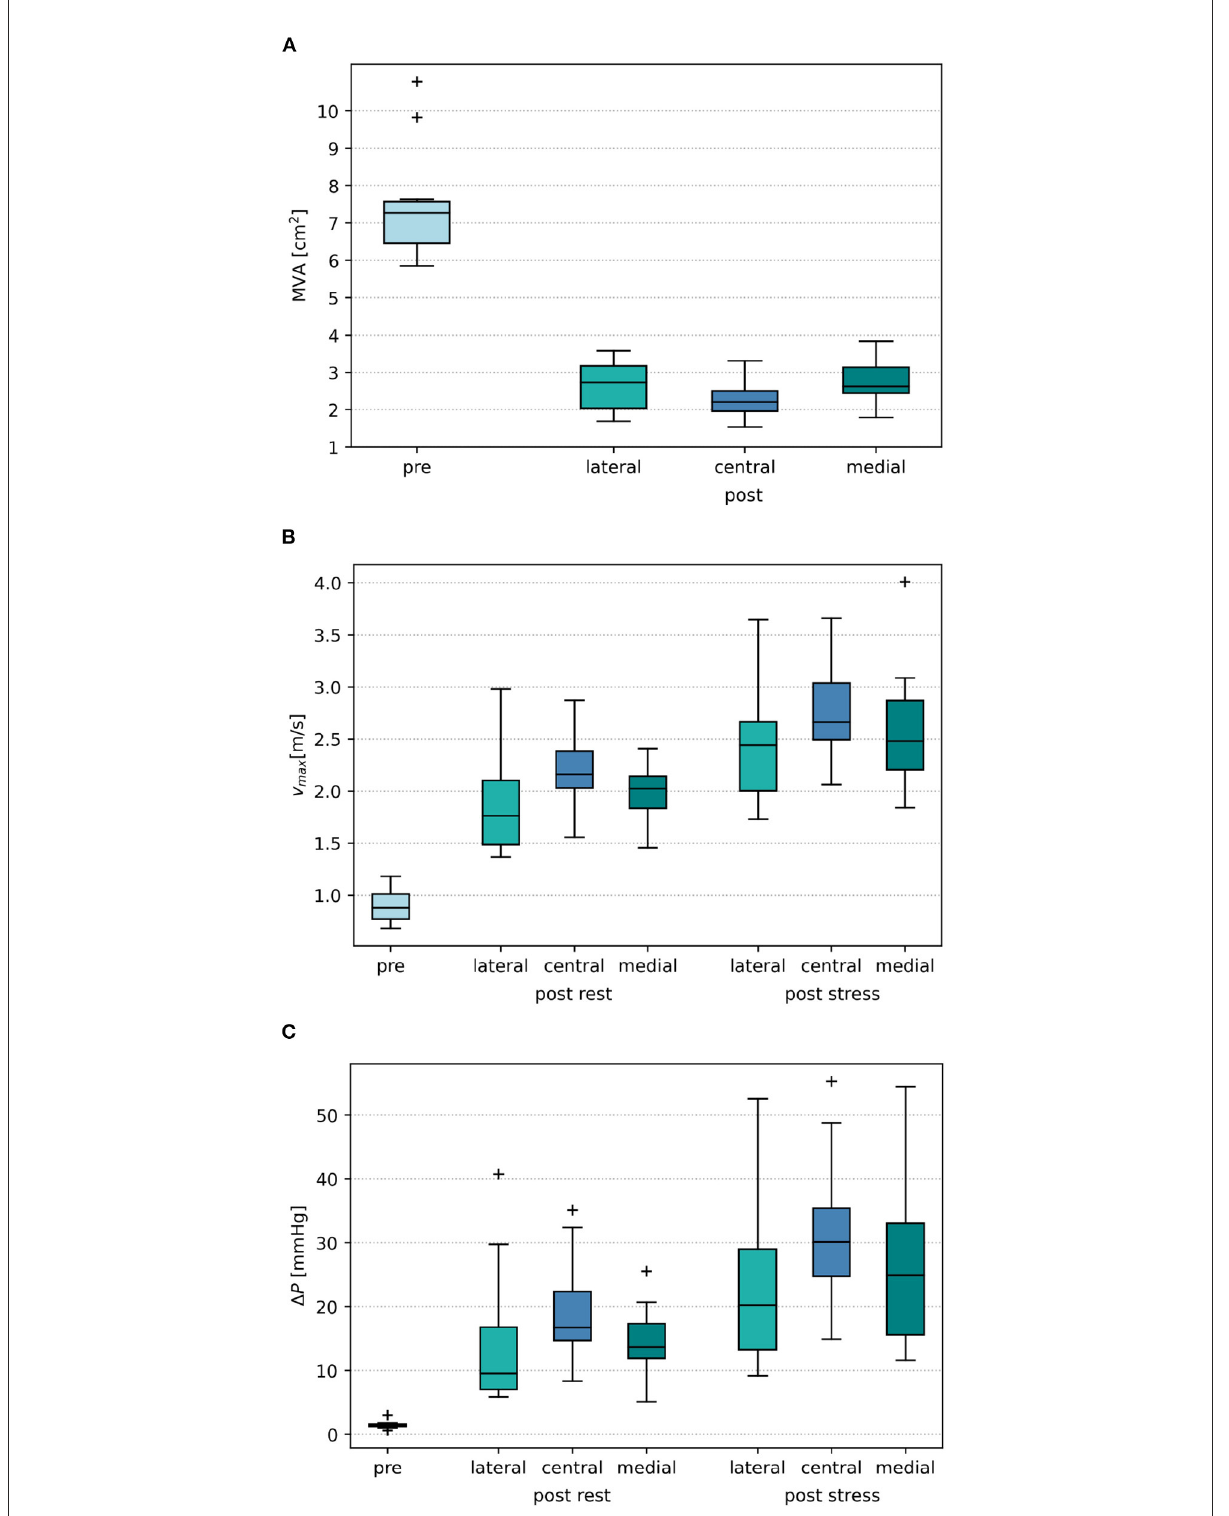
FIGURE7 (A) Boxplot of mitral orifice area (MVA) before virtual treatment (pre) and after virtual TEER placement at the lateral, central, and medial position, respectively. (B) Boxplot of pre- and post-interventional maximal velocities v max . (C) Boxplot of pre- and post-interventional mitral pressure gradient 1 P